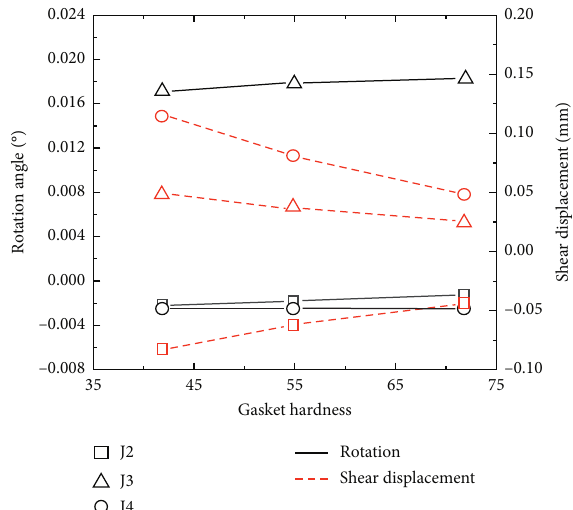
Rotation displacementJ2 Shear J3 Figure 19: Influence of gasket hardness on joint under different gasket hardness rotation and shear